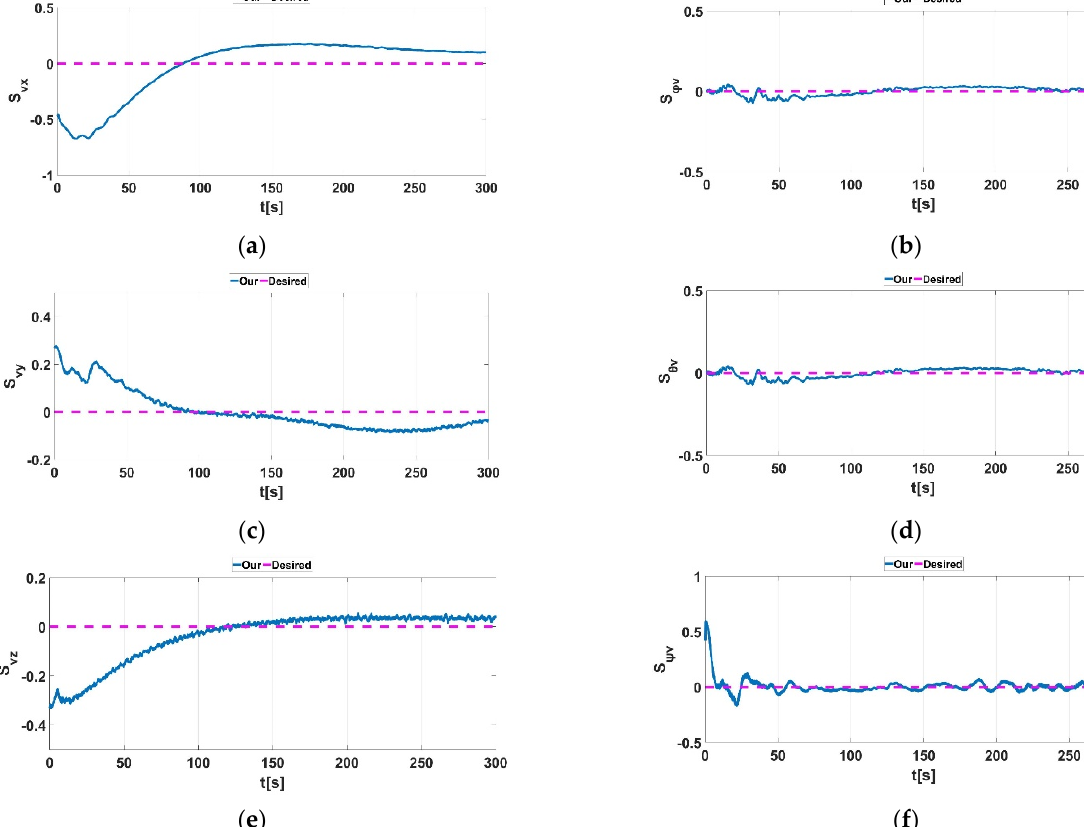
( d ) Figure 17. AUV position − tracking errors. ( a ) 𝑥 (cid:3032) ; ( b ) 𝑦 (cid:3032) ; ( c ) z (cid:3032) ; ( d ) 𝜓 (cid:3032) . Table 5. Average values of 𝐷 𝐸 . RBFPDSMC